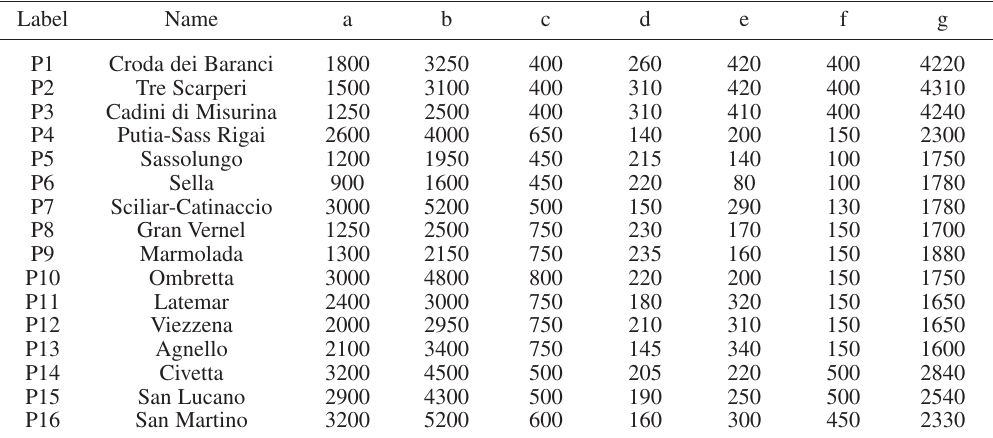
Table II. List of parameters used for modelling the 16 carbonate platforms. Label: platform label used in figs. 6 and 7; a – initial platform radius (m); b – final platform radius (m); c – final platform thickness (m); d – pres- ent-day thickness of the Bellerophon Formation underlying the platform (m); e – present-day thickness of the Werfen Formation underlying the platform (m); f – present-day thickness of the post-Werfen to pre-Late Anisian succession; g – estimated maximum overburden on top of the Werfen Formation.